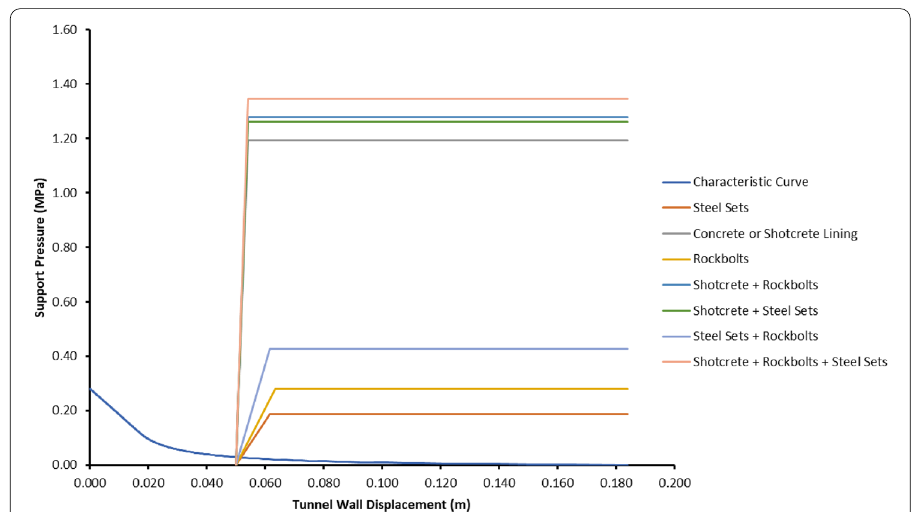
Fig. 12 GRCs and SRCs between the entrance portal and km: 210